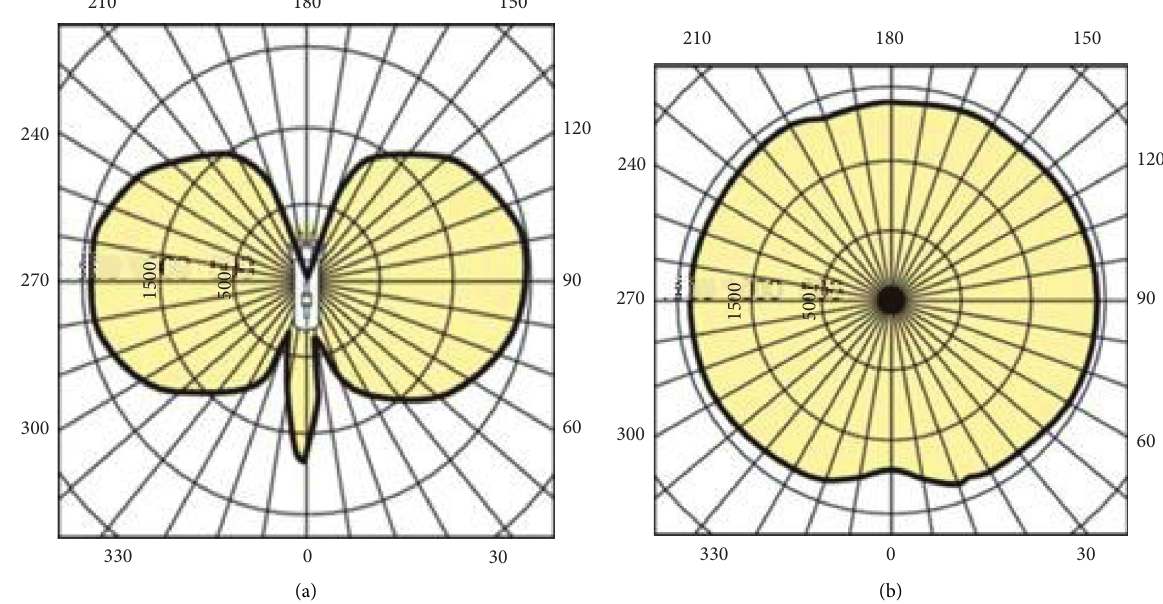
Figure 3: Specified light distribution of the Philips MASTERColour CDM-T Elite 150W/930 G12 1CT/12 bulb [6].